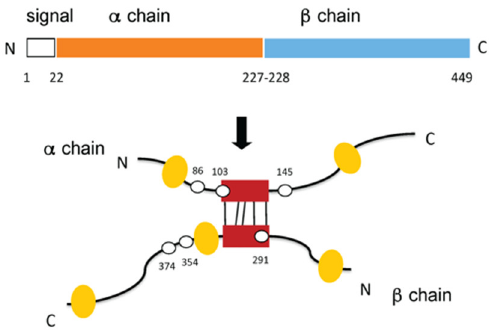
Figure 2. Primary structure of secreted clusterin. Secreted CLU is composed of two polypeptide chains connected by five disulfide bonds, derived from an intracellular precursor. In the first processing step, the 22-mer secretory signal peptide is cleaved from the 449-amino acid precursor. Subsequently the chain is cleaved again between Arg227-Ser228 to generate an a -chain and a b - chain. These are assembled in antiparallel fashion to generate a heterodimeric molecule in which the cysteine-rich centers (red boxes) are linked by five disulfide bridges (black lines). The mature protein is 17–27% N-linked carbohydrate by mass. The three sites for N-linked glycosylation on each chain are clustered around a central region of ordered structure stabilized by the disulfide bonds forming a core that is hydrophilic due to the glycosyl groups. The six sites for N-linked glycosylation are indicated (white ellipses). Five predicted amphipathic a -helices (yellow ovals) in the otherwise disordered arms may be important for binding to hydrophobic regions exposed on misfolded proteins and for insertion into lipid structures. Amino acid numbering for the N- and C-termini, the cleavage sites, and the six sites for N-linked glycosylation (white ovals) are indicated. (From (56) with permission from the publisher, order number 501613529).